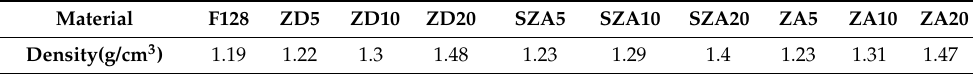
Figure 2. Densities of the tested materials determined by the hydrostatic weighing method.